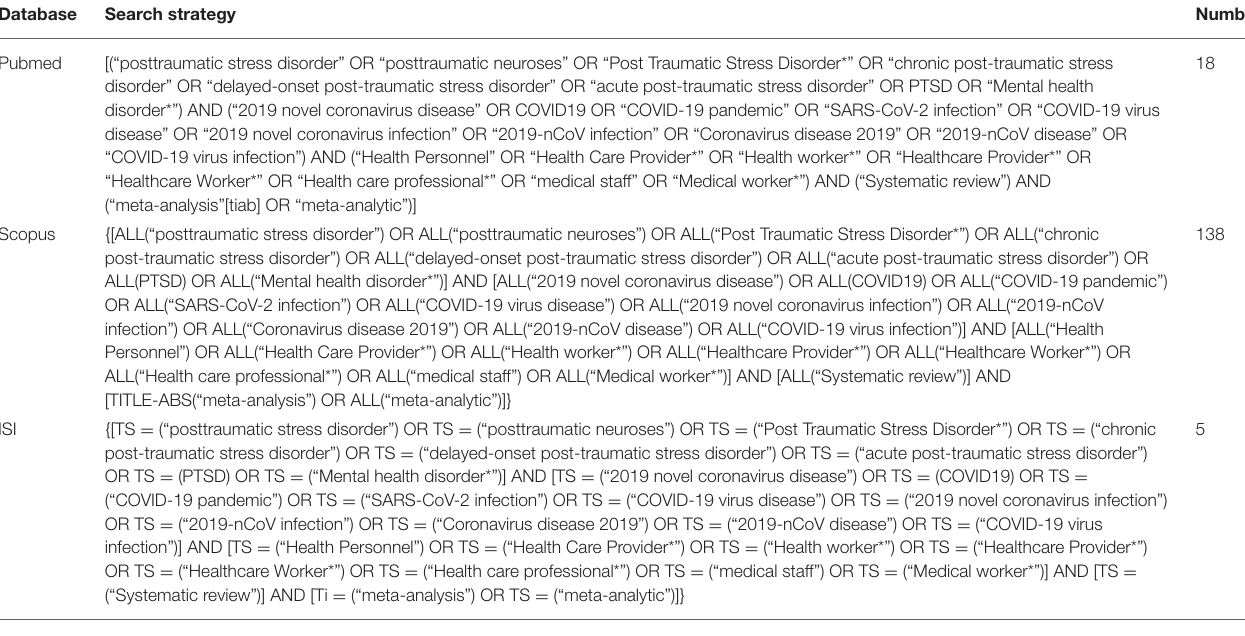
TABLE 1 | Search strategies for various